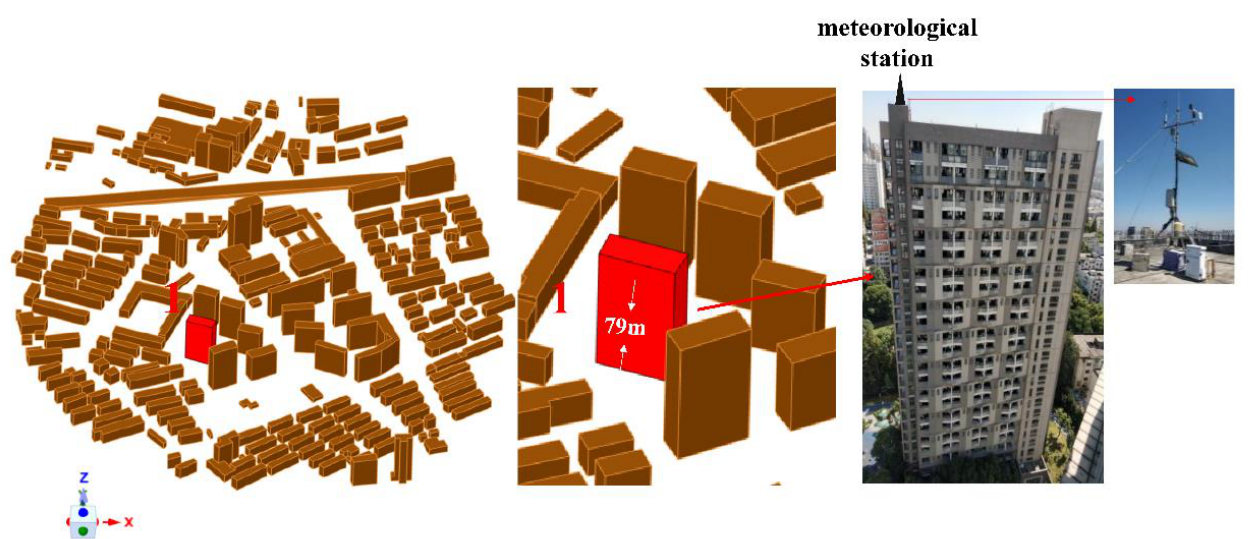
Figure 3. Location and numbering of available experimental data of wind velocity and direction (highlighted in red 1) in Yangpu. The base anemometer, at coordinates ( z = 79 (highlighted in red 1) in Yangpu. The base anemometer, at coordinates ( z = 79 m).